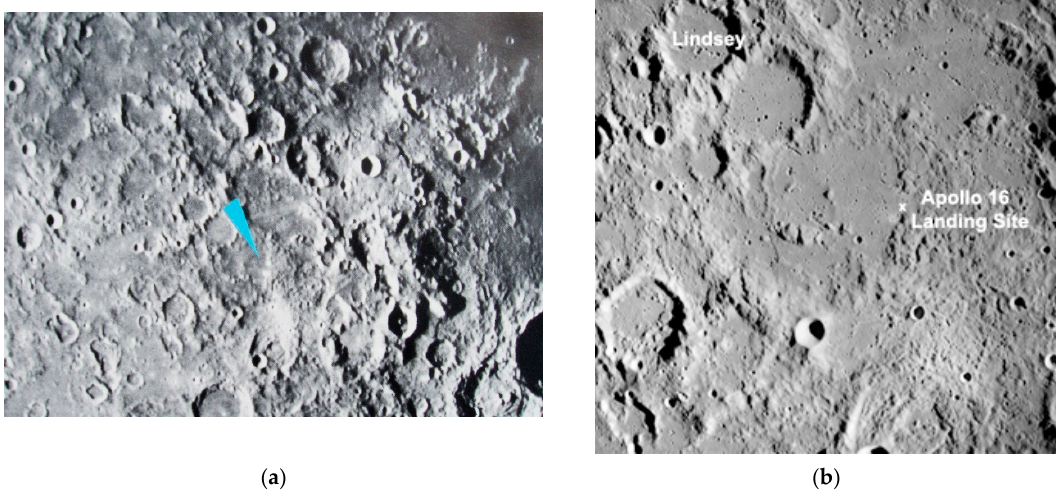
Figure 9. Lunar surface surrounding Apollo 16 landing site at two resolutions. North is at the top. The region on both sides of the landing site is laced by diagonal northwest-to-southeast linear ridges and valleys, which are part of lineament pattern radial to the Imbrium impact basin, parallel to blue arrow near center of image. Imbrium lies far offstage to the upper left. Nectaris impact basin is just out of frame to right, but Imbrium-produced modifications of the landscape dominate over any radial pattern from Imbrium. ( a ) Broad area showing Imbrium-radial lineaments of ~2–4 km width. Width of image is 550 km. Near-center arrow shows landing site. (“Overhead” image, from Rectified Lunar Atlas; Whitaker et al. 1964 [104]) ( b ) Narrower areas showing Imbrium-radial detail at scales of ~1–2 km width. Width of image is 175 km (Orbital image).